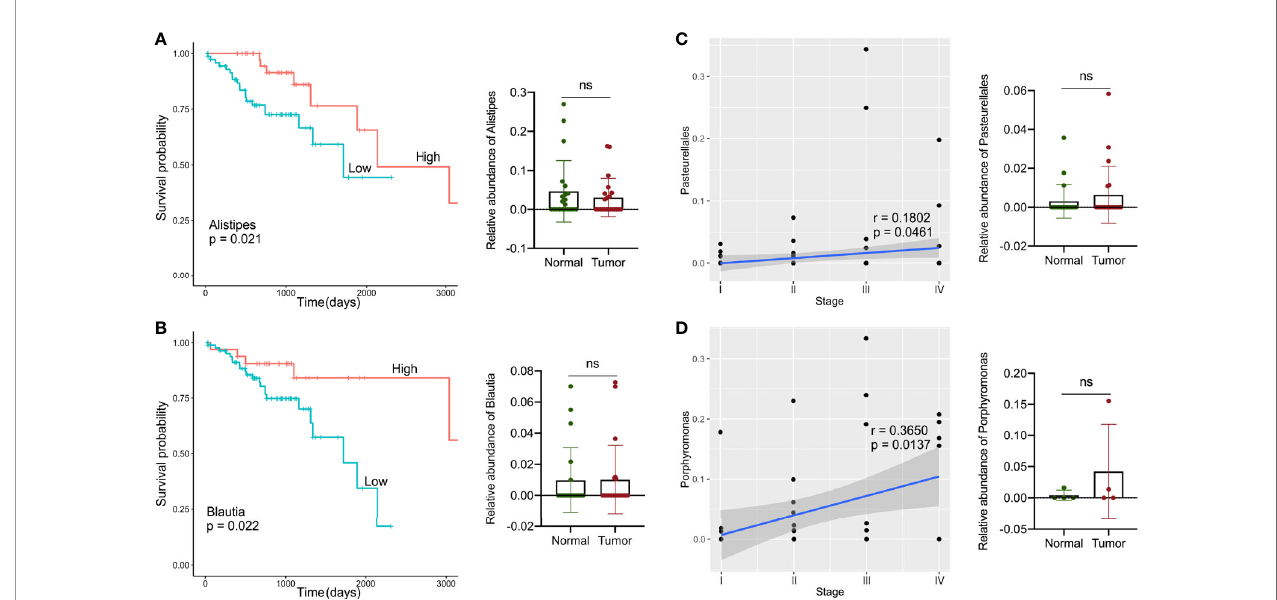
FIGURE 5 | Analysis of correlations between speci fi c microbes and the clinical characteristics or survival status in GI cancers. (A, B) Kaplan – Meier survival curves based on microbial abundances of Alistipes (A) and Blautia (B) , and calculation of their abundance in COAD tumor and paired normal samples. (C) Correlation of Pasteurellales abundance with the tumor stage, and calculation of Pasteurellales abundance in COAD tumor and paired normal samples. (D) Correlation of Porphyromonas abundance with tumor stage, and calculation of Porphyromonas abundance in READ tumor and paired normal samples. COAD, colon adenocarcinoma; READ, rectum